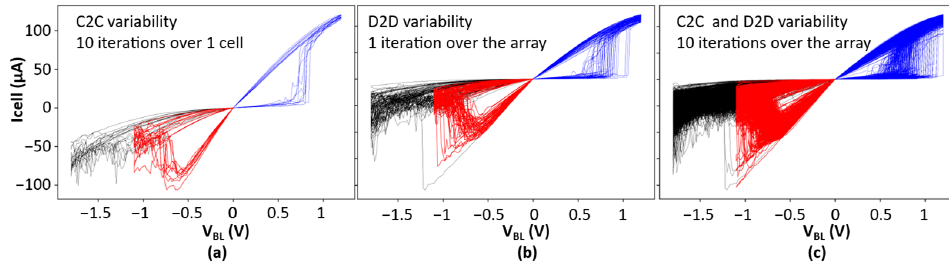
Figure 7. I–V curves extraction after the RST 1 -SET-RST 2 operation highlighting ( a ) C2C variability, ( b ) D2D variability, and ( c ) both C2C and D2D variability. D2D variability is confirmed in Figure 8a–c bitmaps, extracted after RST 2 operation for 3 different V stop values (0.6 V, 1.1 V, and 2 V). Resistance values are represented by a color gradient from white (for the highest resistance values) to black (for the lowest resistance values). For V stop = 0.6 V, the resistance window is [5.8–13 k Ω ], with an average value of 7.5 k Ω . For V stop = 1.1 V, the resistance window increases to [30–180 k Ω ], with an average value of 88 k Ω . The resistance window is even more increased for higher V stop values: the deeper we enter the HRS state, the higher the variability [27]. For V stop = 1.6 V, a resistance window of [92–496 k Ω ] is measured, with an average value of 237 k Ω .